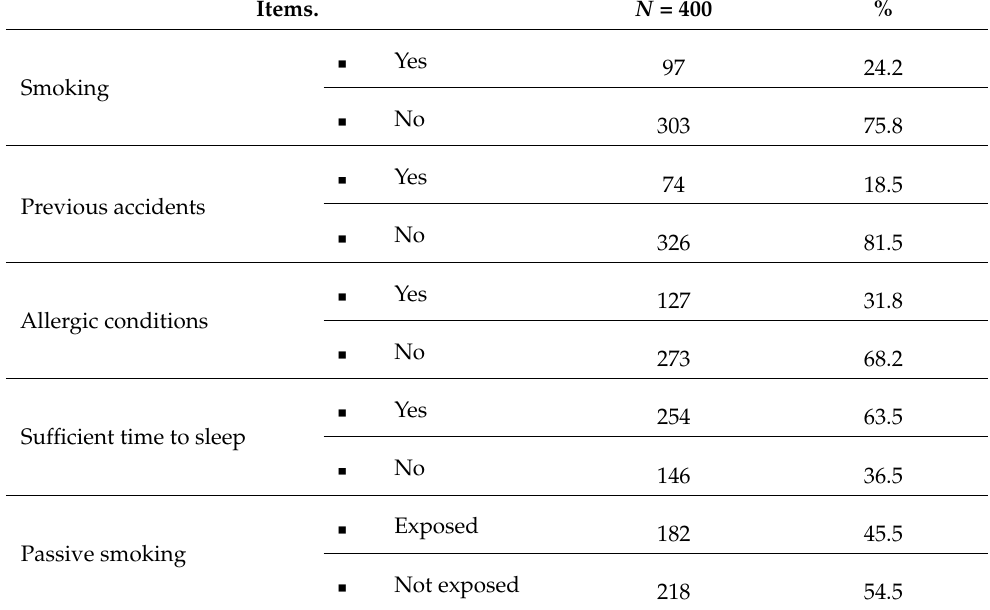
Table 2. Health history of patients in the study.